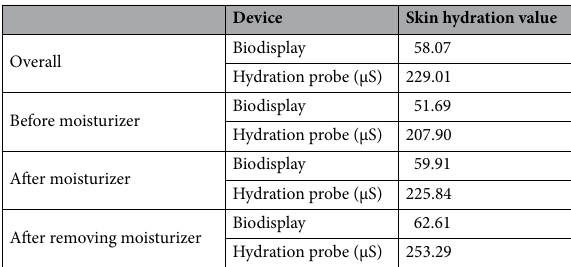
Table 2. Average skin hydration values of Biodisplay and hydration